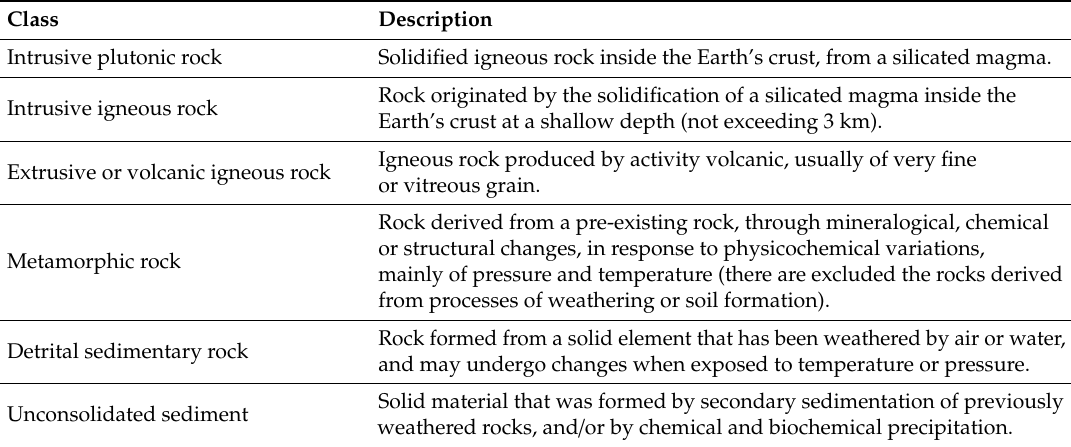
Table 1. Description of the reclassified geological classes from the Spanish national geological